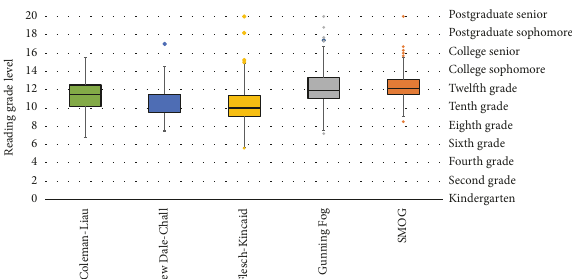
Figure 3: Box and whisker plot depicting distribution of readability grade levels as measured by different readability metrics. SMOG: Simple Measure of